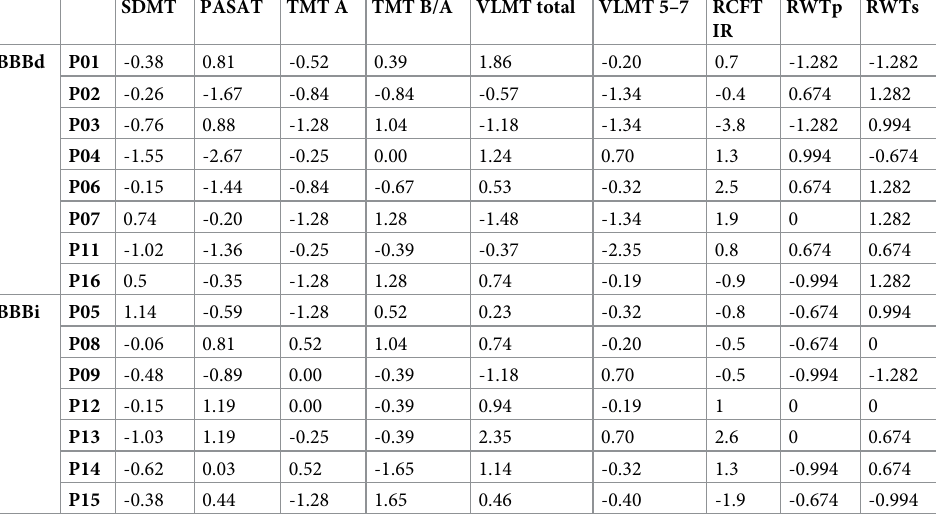
Table 5. Individual z-score profiles of the chronic autoimmune demyelinating polyneuropathy (CADP) patients. RCFT IR = Immediate Recall trial in the Rey Complex Figure Test; SDMT = Symbol Digit Modalities Test; VLMT total = total number of correctly recalled items in trials 1 to 5 of the Verbaler Lern- und Merkfa¨higkeitstest; VLMT 5–7 = “trial 7”–“trial 5” difference in the VLMT; PASAT = Paced Auditory Serial Addition Test; TMT = Trail Making Test; RWT p/s = phonemic/semantic subtests of the Regensburger Wortflu¨ssigkeits-Test. BBBd = blood-brain-barrier dys- functional; BBBi = blood-brain-barrier